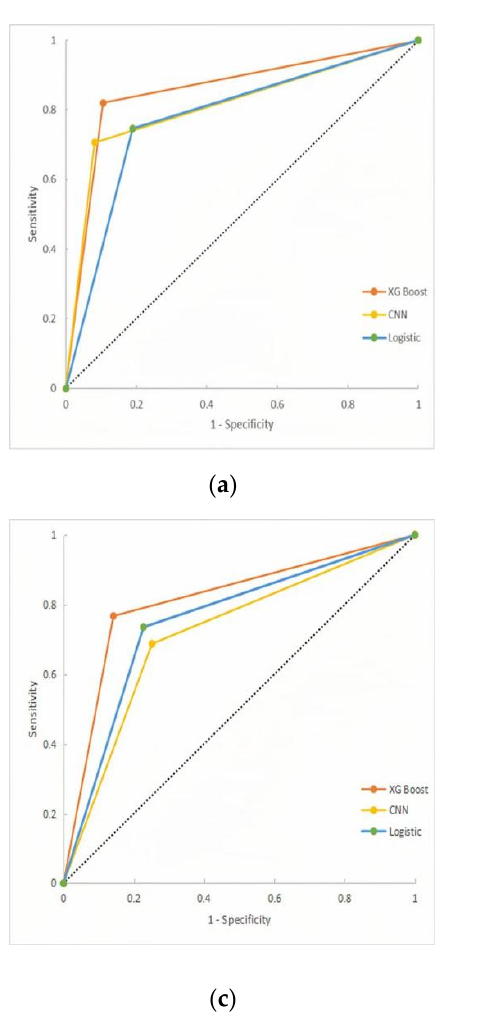
Table 8. AUC comparison of three models.